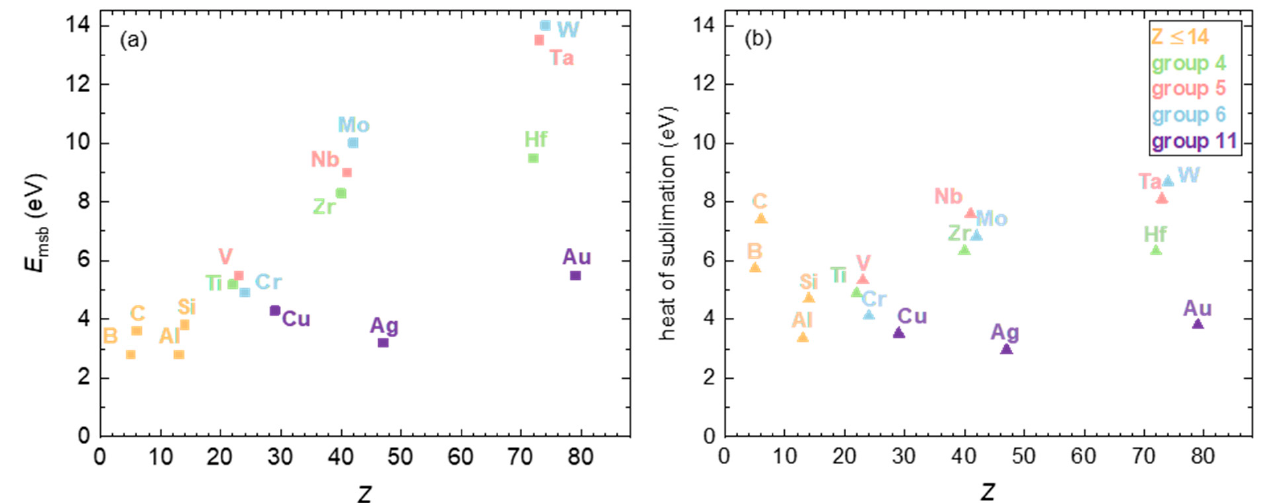
Figure 10. ( a ) The modified surface binding energy in dependence of the atomic number used in our SRIM simulations. ( b ) The heat of sublimation, which is used in SRIM as the default value for SBE, in dependence of the atomic number.